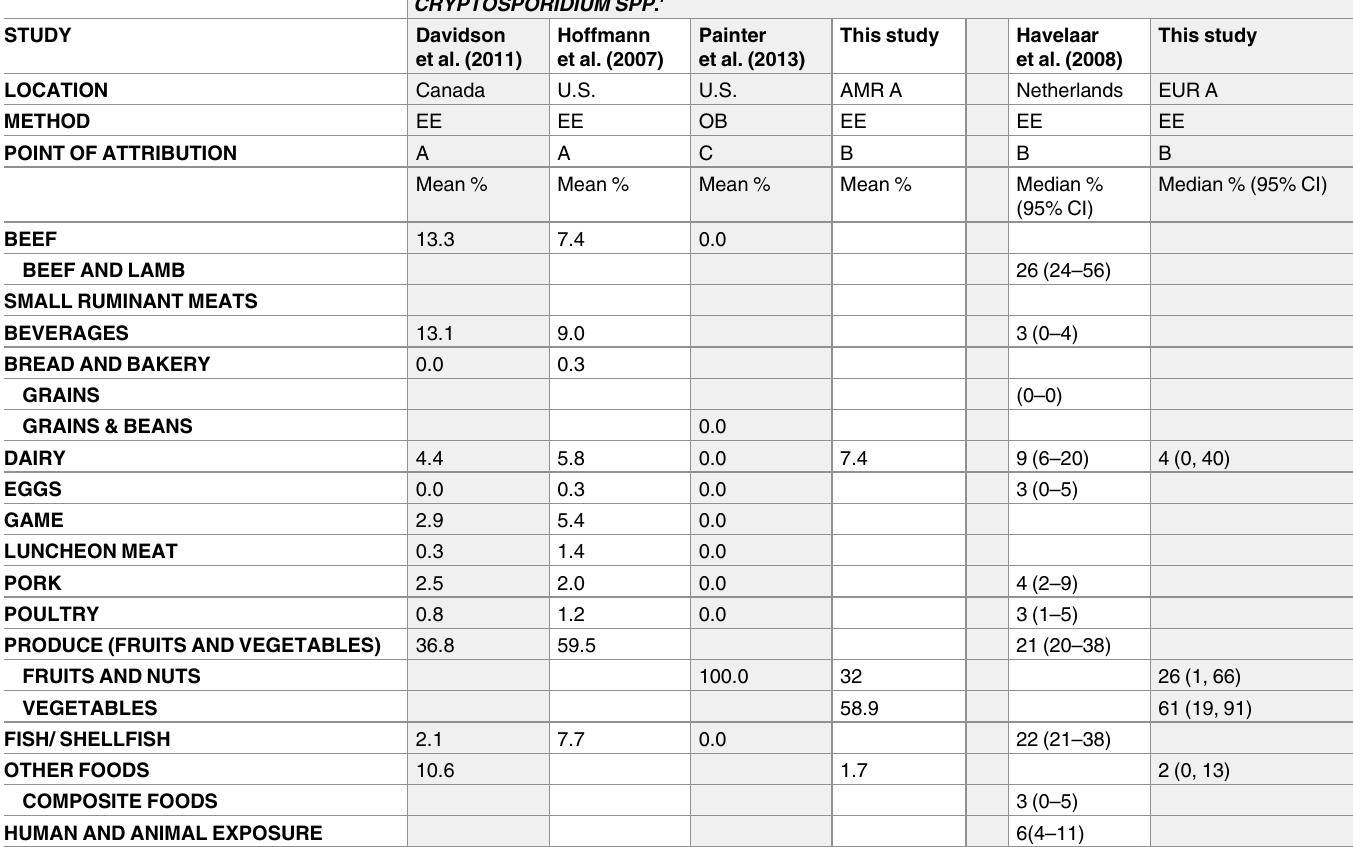
Table 4. Cryptosporidium spp. Percent of foodborne illnessesattributed to specifiedfood exposures from prior national studies and this study *